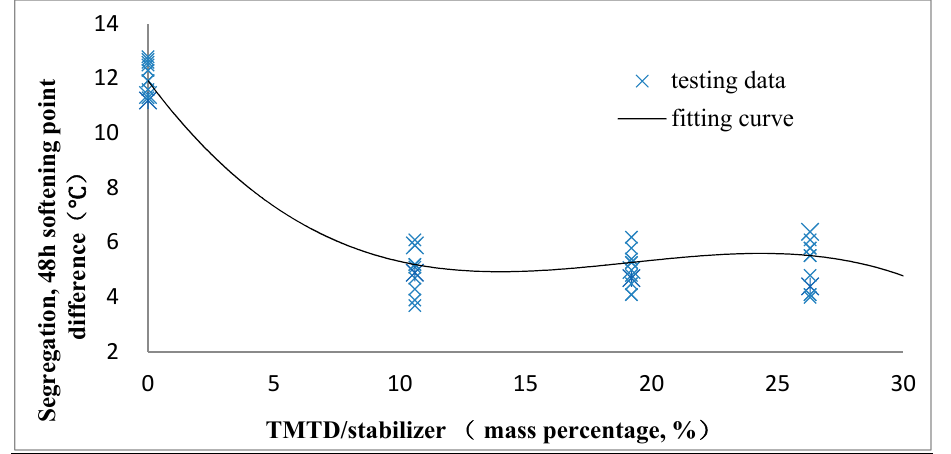
Figure 5. The 48-h segregation softening point with different TMTD content.